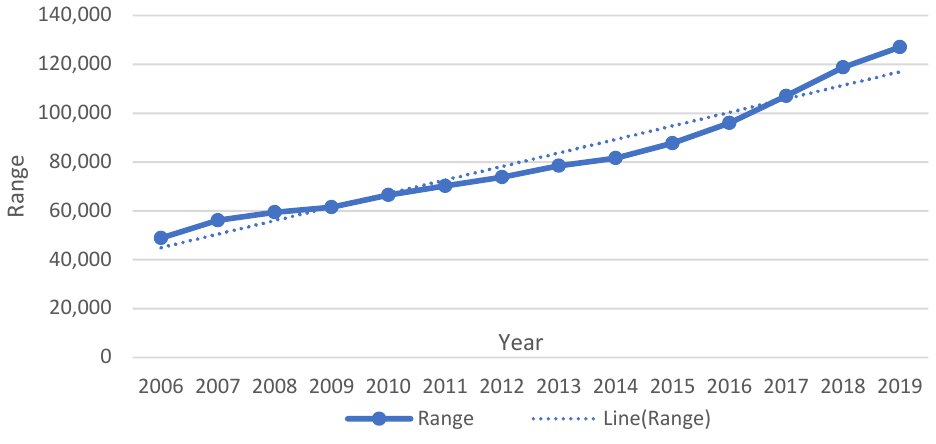
Land 2023 , 12 , x FOR PEER REVIEW